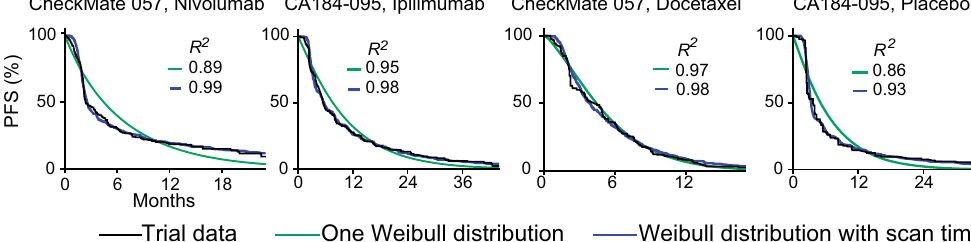
Fig. 3 Fit of Weibull models to progression-free survival and overall survival data for trials of immune checkpoint inhibitors. a PFS distributions and b OS distributions for individual arms of two trials of immune checkpoint inhibitors (NCT01673867, NCT01057810) with fi t to either one or two Weibull distributions. PFS data are best described by using a mixture model of two Weibull distributions, each with two parameters. OS distributions are described equivalently well by a one or two-distribution fi t. c PFS simulations that account for the periodicity of radiological scans to detect progression improve the quality of one-distribution Weibull fi ts, as quanti fi ed by the coef fi cient of determination ( R 2